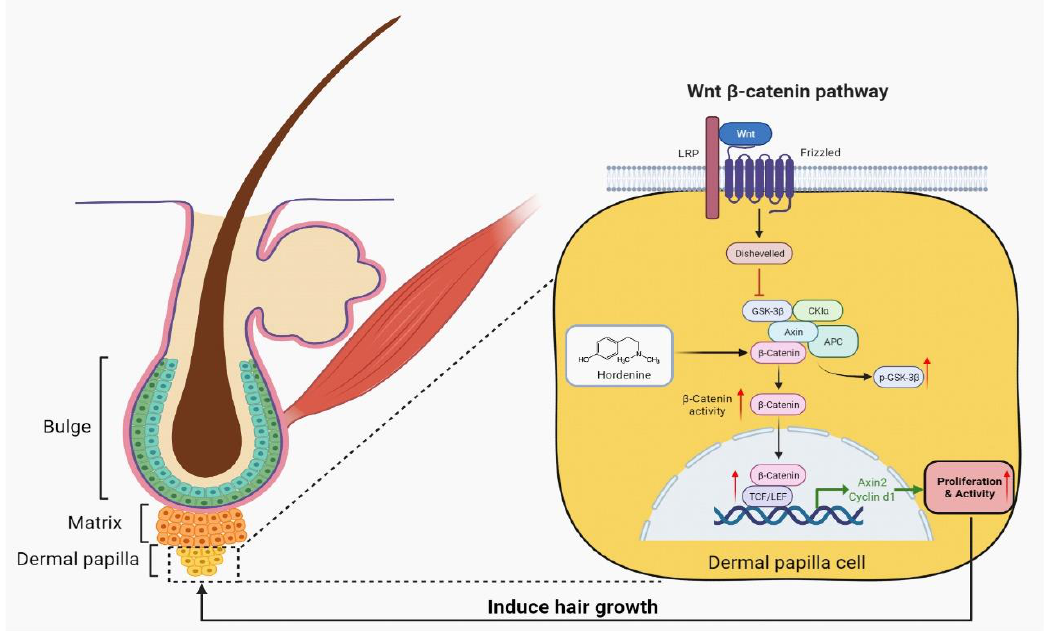
Figure 6. A model of promoting effects of Hordenine on hair regeneration. Hordenine significantly increased the proliferation of DPCs and enhanced their activity by activating Wnt/β -catenin signaling pathway, thus effectively promoting the elongation of hair shaft of mouse vibrissa follicles and accelerating hair regeneration in mouse dorsal skin.